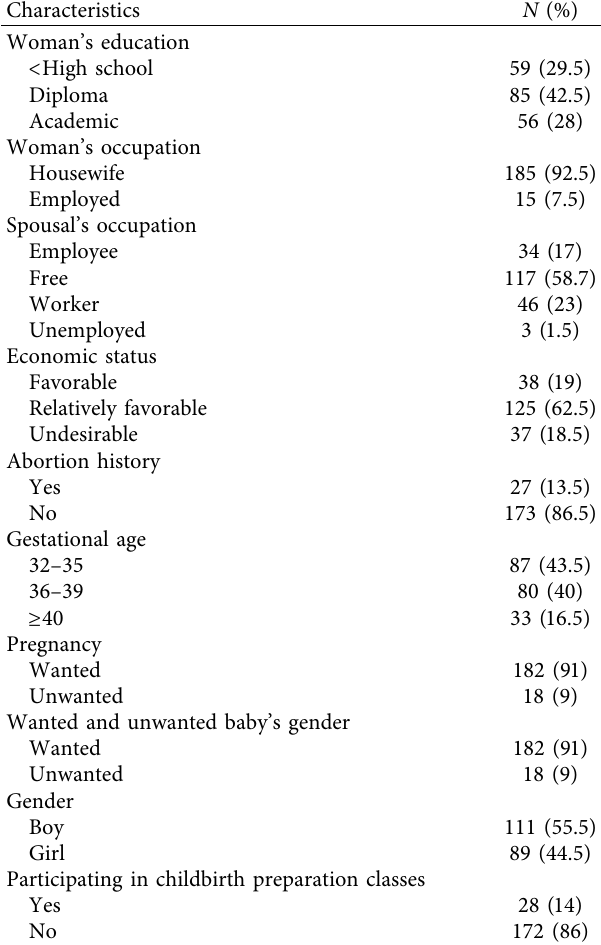
Table 1: Demographic and fertility characteristics of the partici- pants ( n � 200).